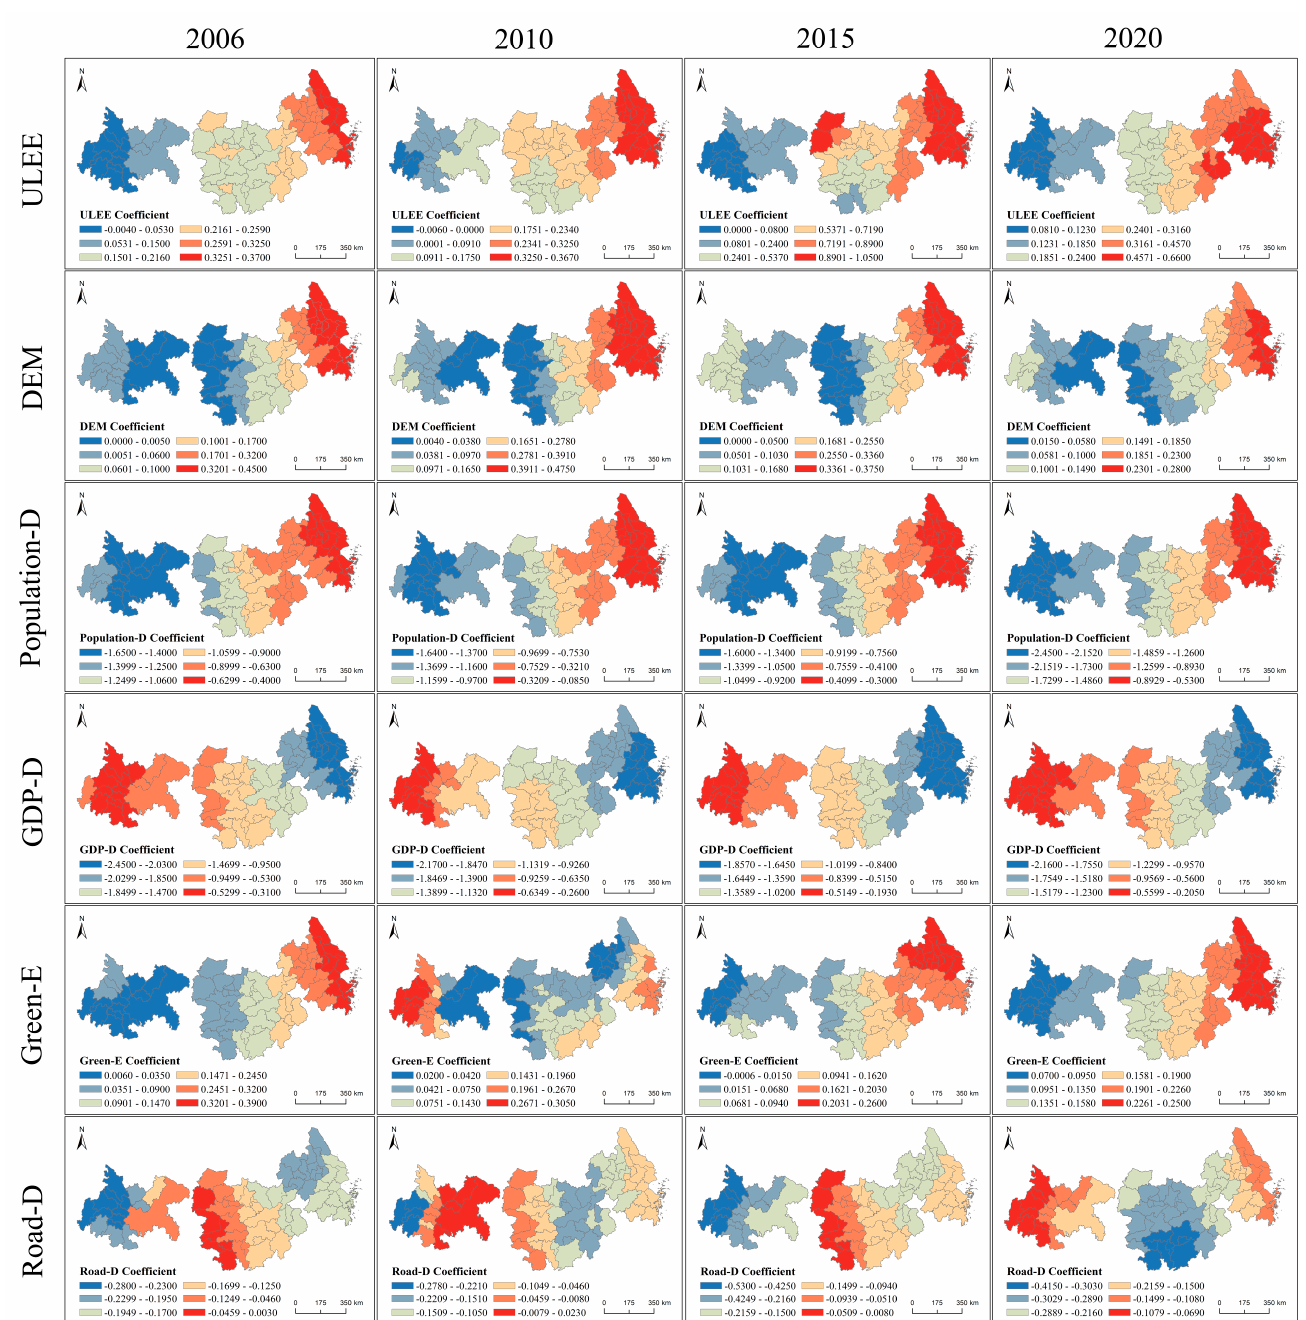
Figure 7. Spatial distribution patterns of impact indicators of ESs in three major urban agglomera- tions.